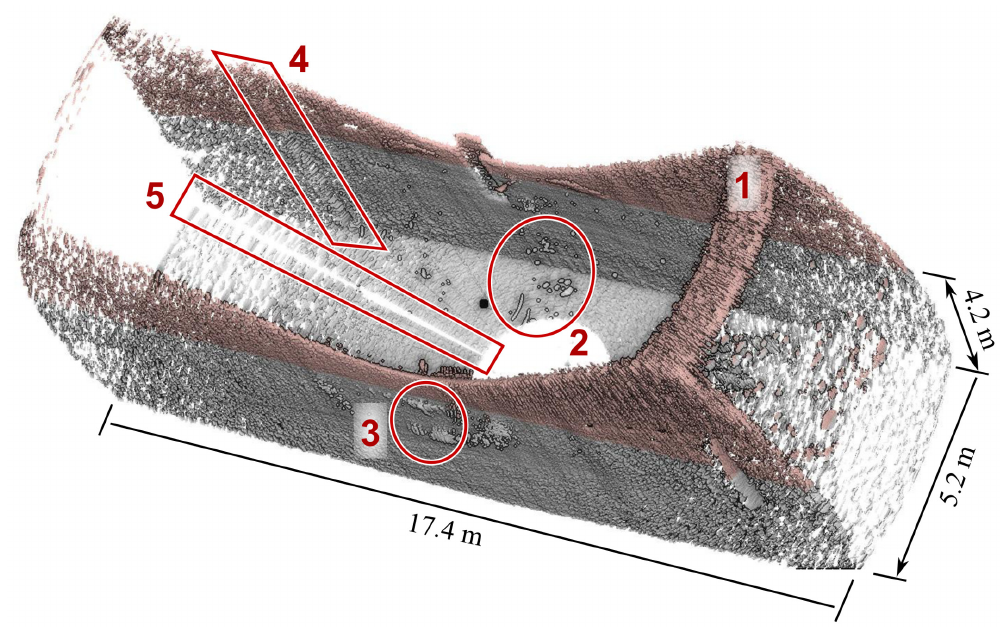
Figure 8. Rendering of a raw sonar output (from a single scanning position on the lock chamber floor). 1: artifacts due to surface reflections (coloured in salmon). 2: acoustic anomalies in the water column. 3: acoustic phenomena due to signal backscattering. 4: acquisition anomaly probably due to a temporary blocking of the horizontal rotation system. 5: lack of